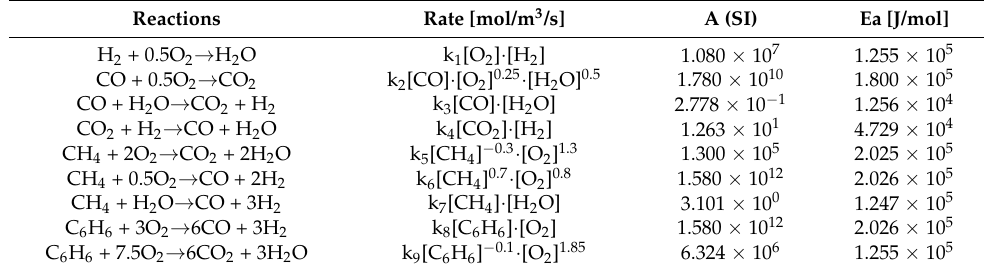
Table 5. Homogeneous reactions in the gas phase